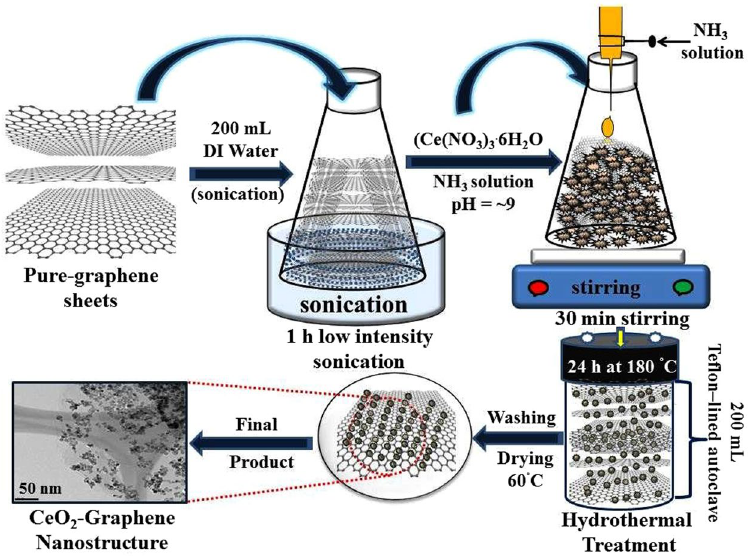
Figure 12. Schematic representation for the synthesis steps of the CeO 2 -Graphene